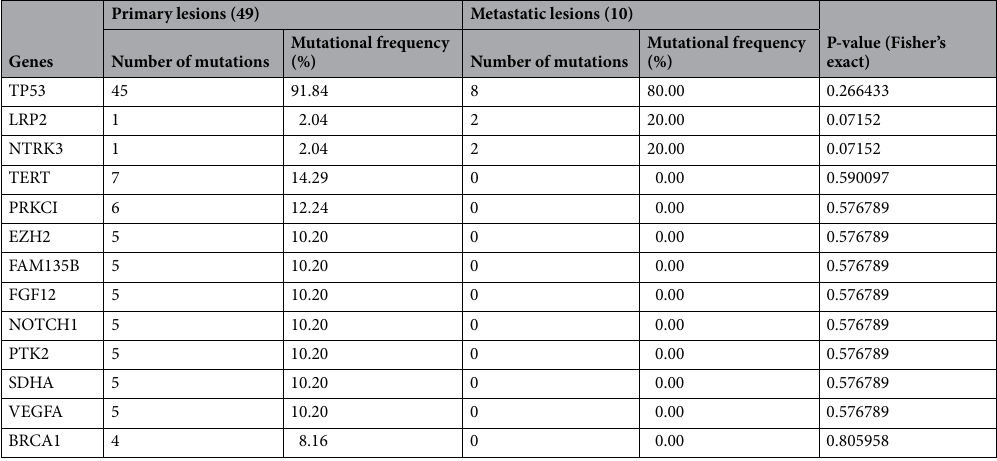
Table 2. Correlation analysis between mutated genes and the origin of tumor samples.